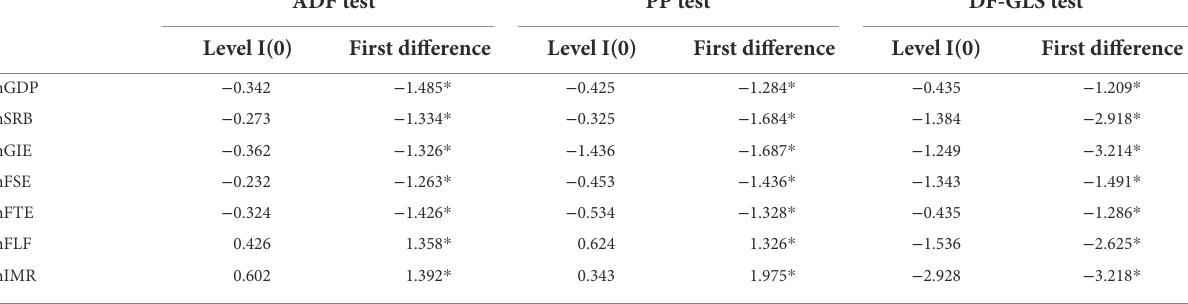
TABLE 2 ADF, PP, and DF-GLS unit root test.